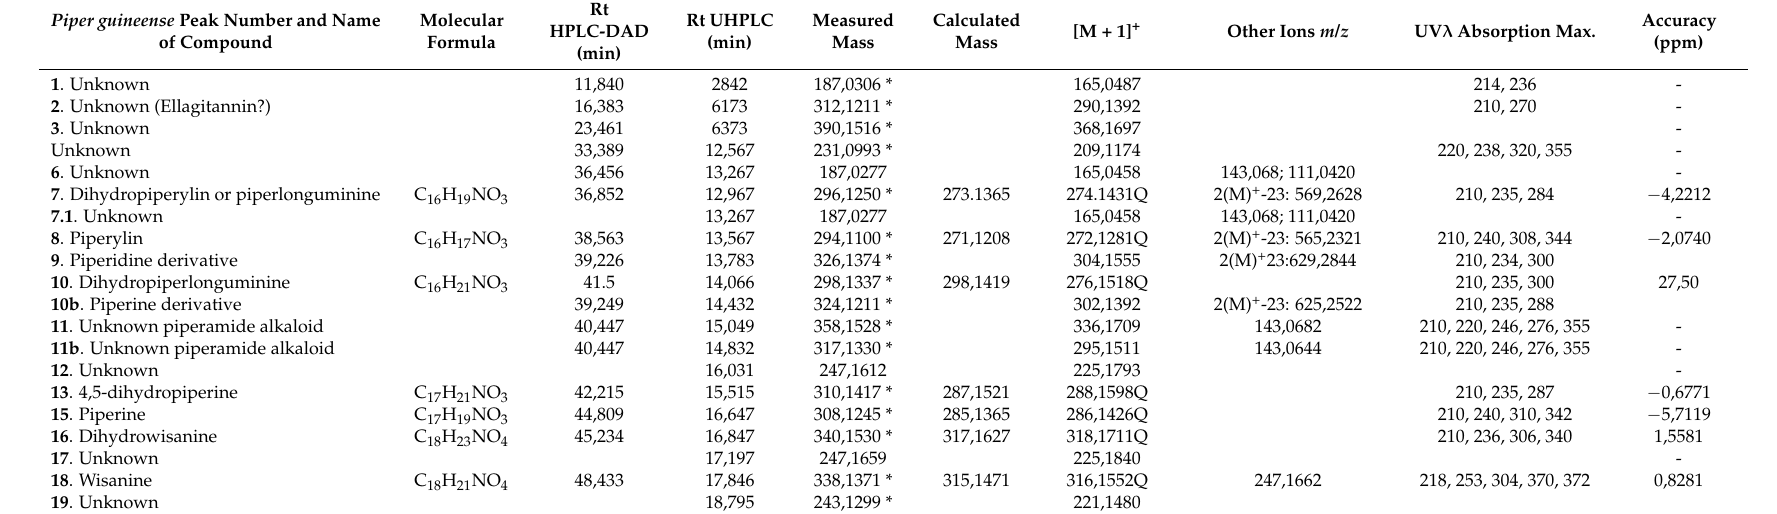
Table 4. HPLC-DAD and UHPLC/QTOF-MS data of alkaloids from a Piper guineense leaf hexane